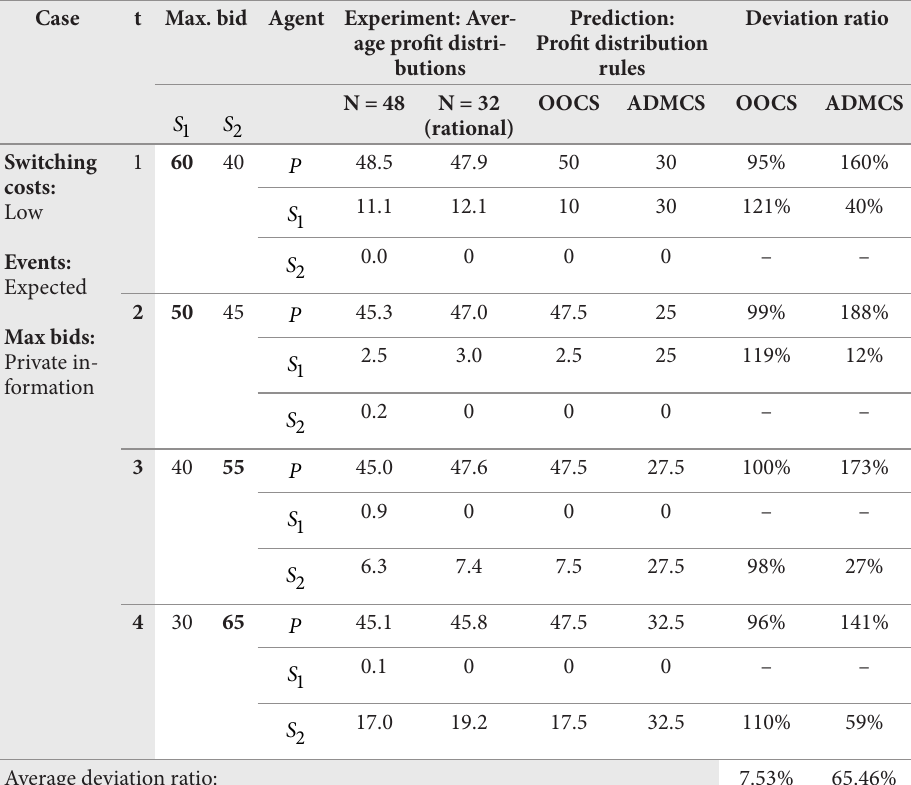
Table 2. Maximal bids and the comparison of the OOCS-rule and the ADMCS-rule with the empirical results for low agent switching costs and maximal suppliers’ bids that are private